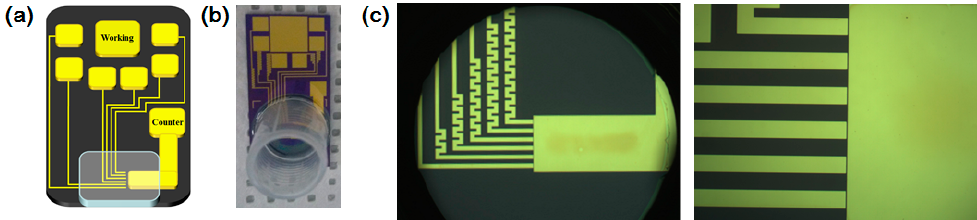
Figure 2. ( a ) Schematic diagram of micro-gap electrode; ( b ) Optical image of fabricated micro-gap electrode with working chamber for H 2 O 2 biosensor application; ( c ) Optical image of zoomed micro-gap.